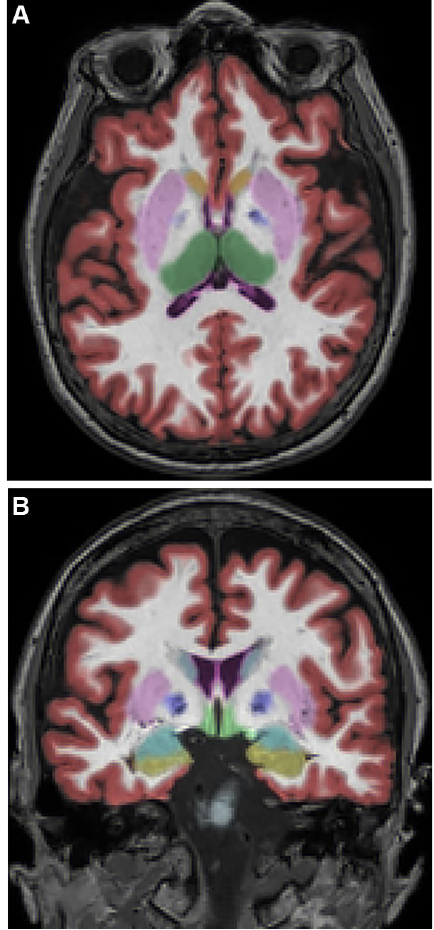
Figure 2. ( A , B ). Examples of automated color-coded segmentation results obtained with NeuroQuant. Light blue, caudate; pink, putamen; blue, pallidum; green, thalamus; cyan, amygdala; yellow, hippocampus; red, cortical grey